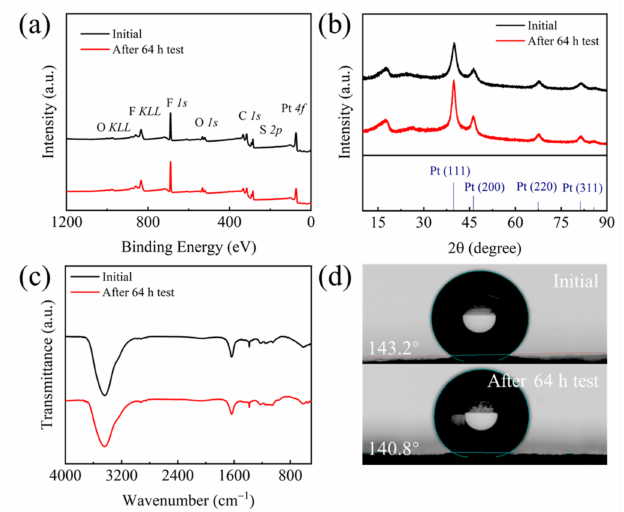
Figure 9. ( a ) XPS survey spectra, ( b ) XRD patterns, and ( c ) FTIR spectra of the cathodic catalyst layer before and after the 64 h test. ( d ) Contact angle test of the cathodic gas diffusion layer before and after the 64 h test. Table 2. Elemental composition and content before and after the 64 h test.